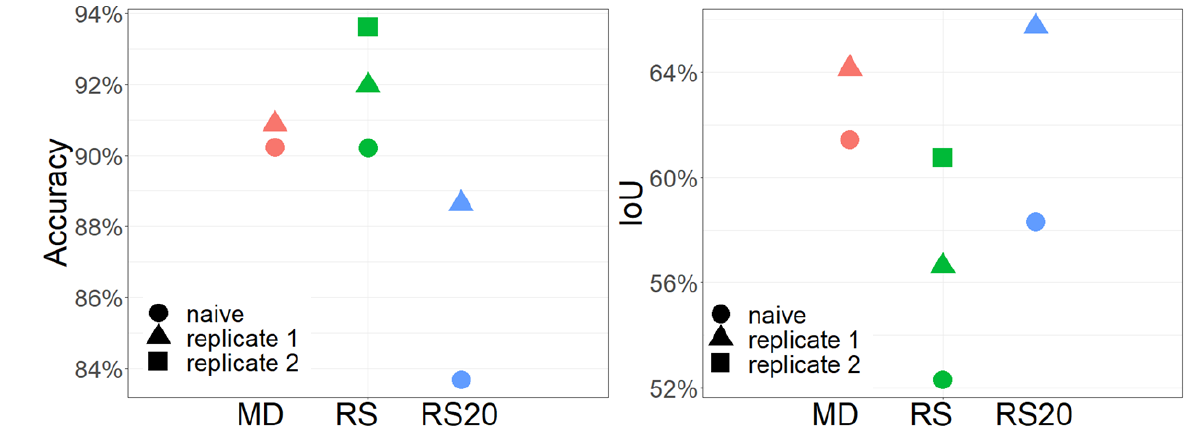
Figure 11. Results of the orthorectification experiment. Treatments are signified in shape, and data-sets are from left to right. No-leveler (naïve, circle) is always inferior to the replicates (triangle and square). Accuracy ranges from 82 to 92 percent and IoU ranges from 52 to 64 percent.